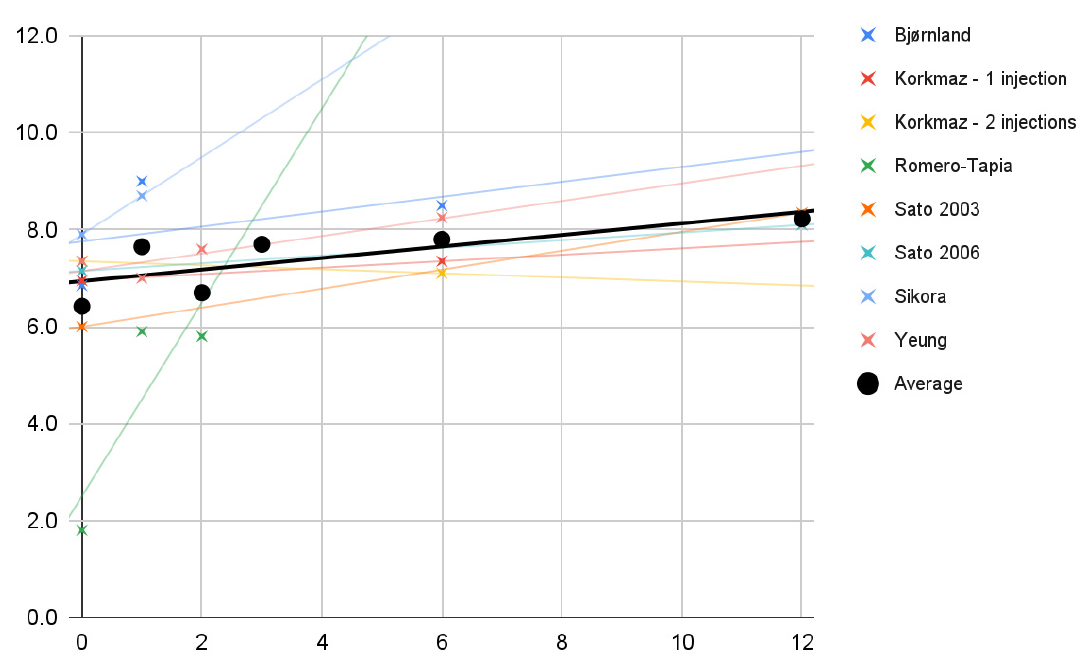
Figure 5. Changes in the average range of mandibular lateral movements (mm) over time (months). Description in the text.